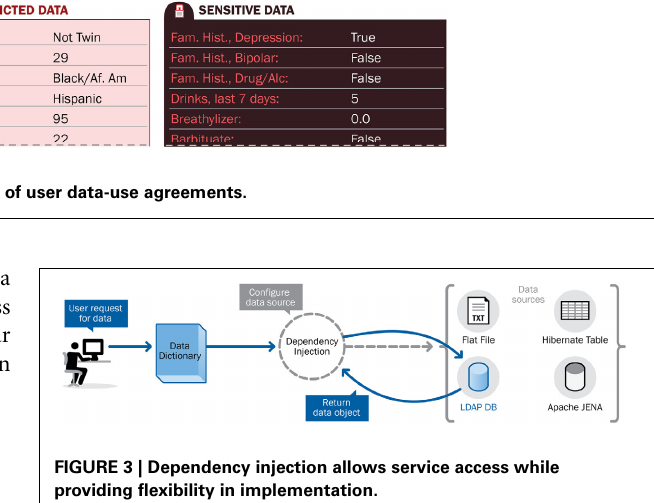
Notation (JSON)-formatted 6 configuration file that is read by the dictionary service on